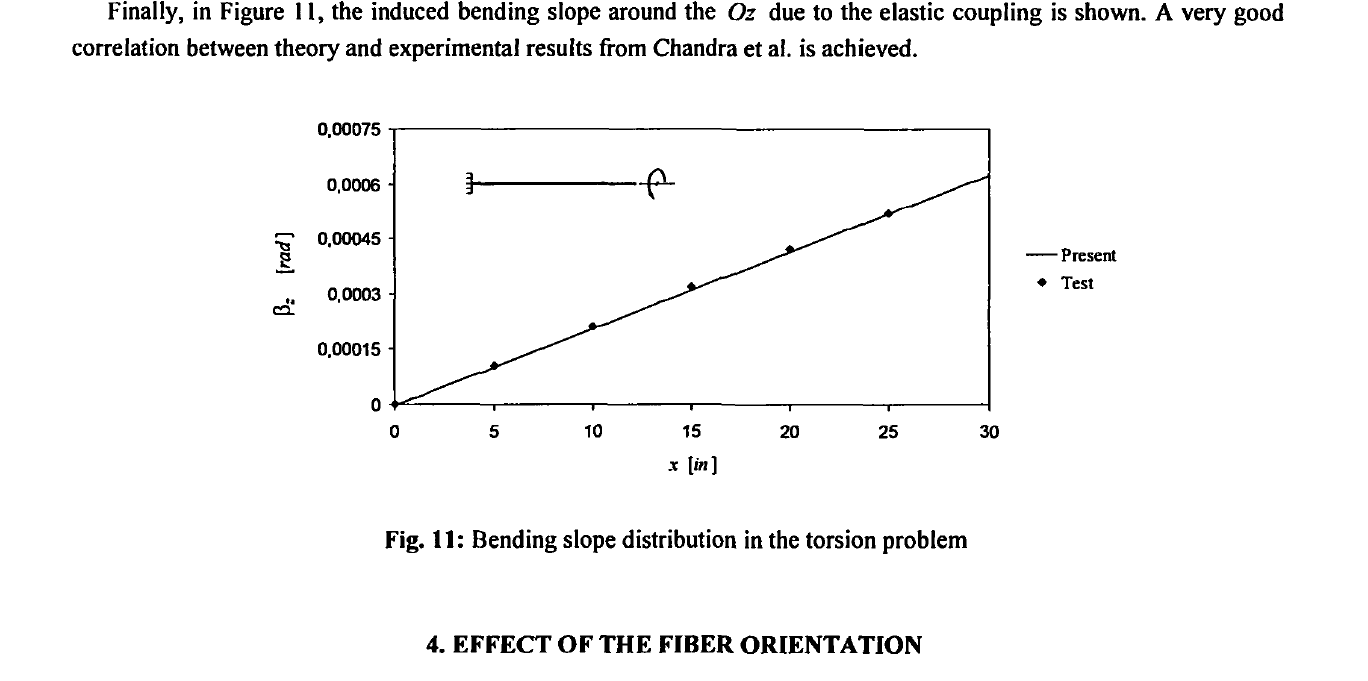
Fig. 11: Bending slope distribution in the torsion problem